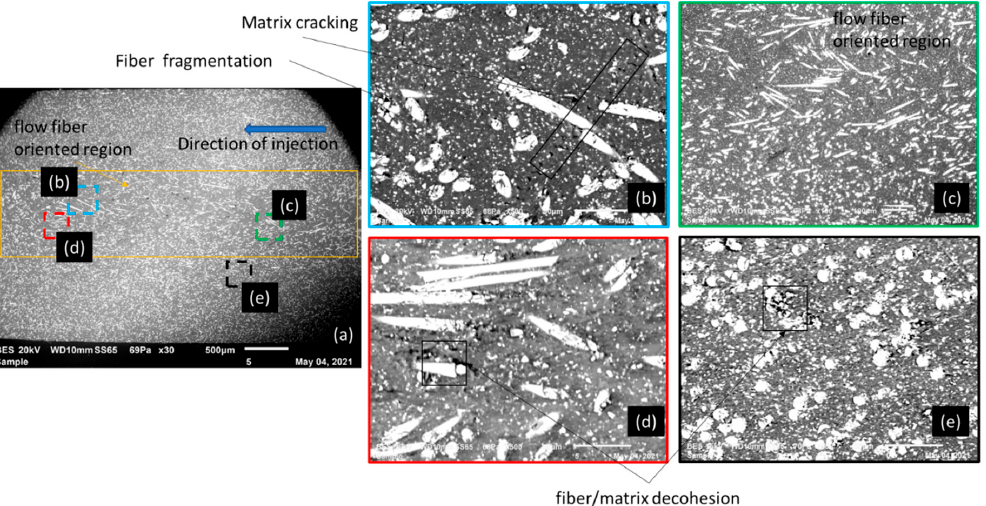
Figure 8. SEM micrographs of the transverse surface of a fractured tensile sample with 30% GF/PBT composite, 20 kV, 10 mm working distance, 69 Pa: ( a ) BES macro-image with flow fiber-oriented region; ( b – d ) zoom of different regions in the zone ( a ); ( e ) homogeneous zone.